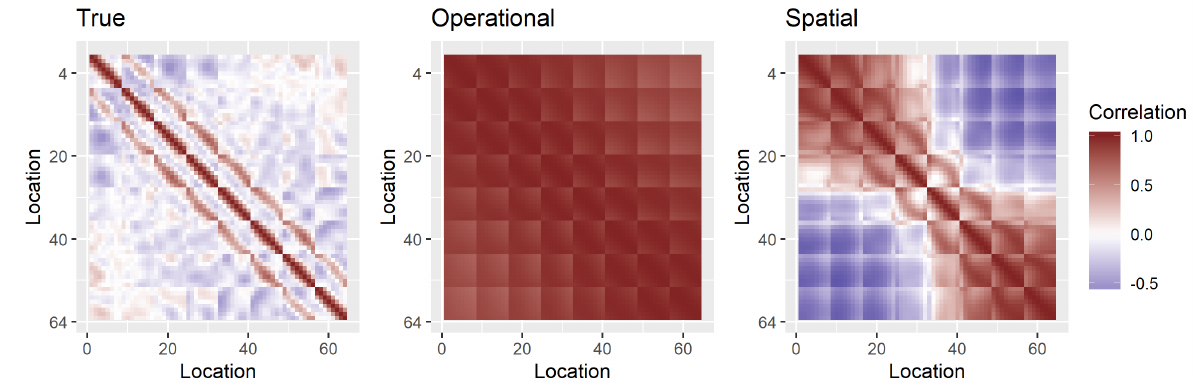
Figure 6. XCO retrieval error correlations across locations for 100 samples for the October 2015 Lamont template. Typical 2 operational priors lead to predictions with errors that have strong spatial correlation.